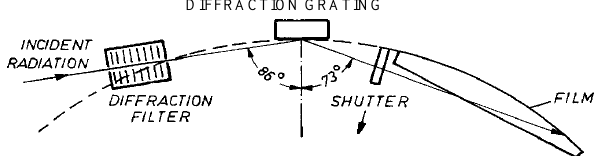
Figure 7: Arrangement of the spectrophotometer recording the solar XUV radiation as presented in Figure 6 (Schweizer and Schmidtke, 1971; © AAS. Reproduced with permission).